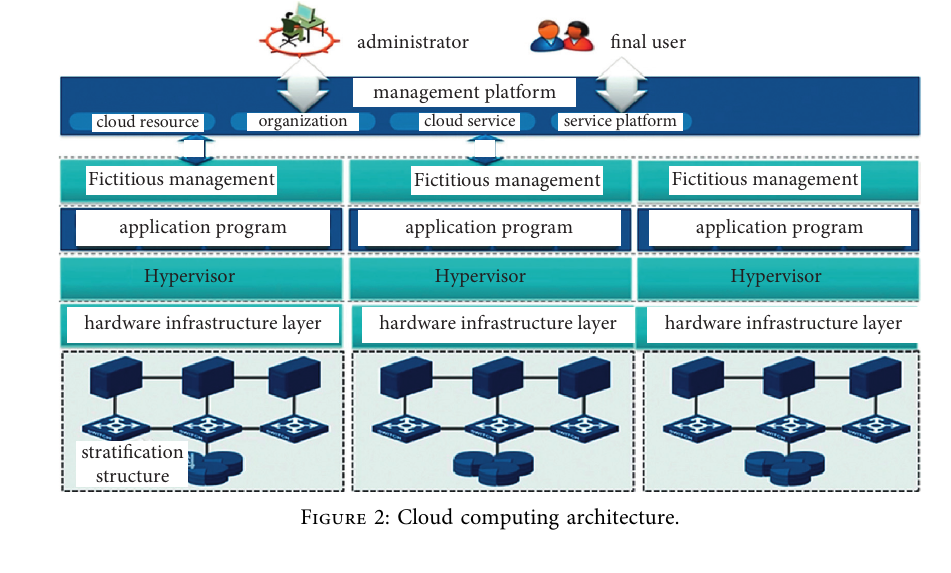
Figure 2: Cloud computing architecture.